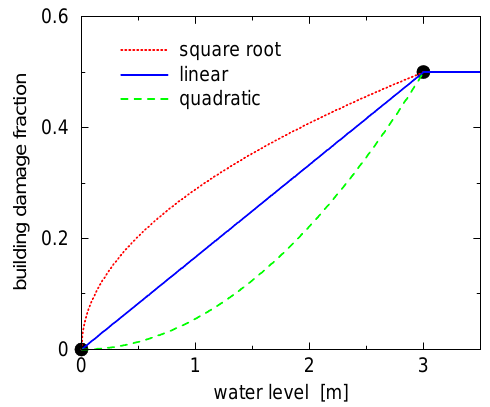
Fig. 2. Assumed building damage functions according to Eqs. (1), (3), and (4). The fraction of building damage (without inventory) is plotted against the water level from the lower edge of the building. The parameters of the linear, square root, and quadratic building damage function are determined by two anchor points, i.e. no dam- age for no inundation and 50% damage at 3m